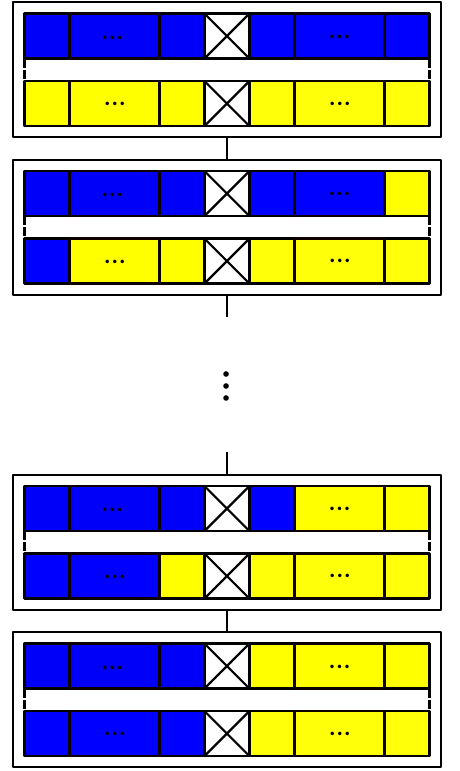
Figure 11. The tree of descendants for E 7 with N f 56 where N f is a half-integer. Decoupling one full hypermultiplet descends down the